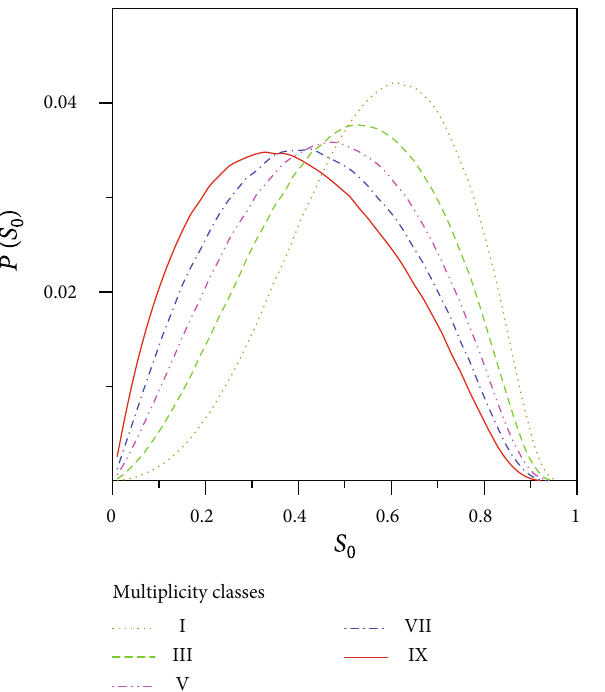
Figure 2: (Color online) Spherocity distribution for di ff erent multiplicity classes in pp collisions at Di ff erent colors and line styles are for di ff erent multiplicity